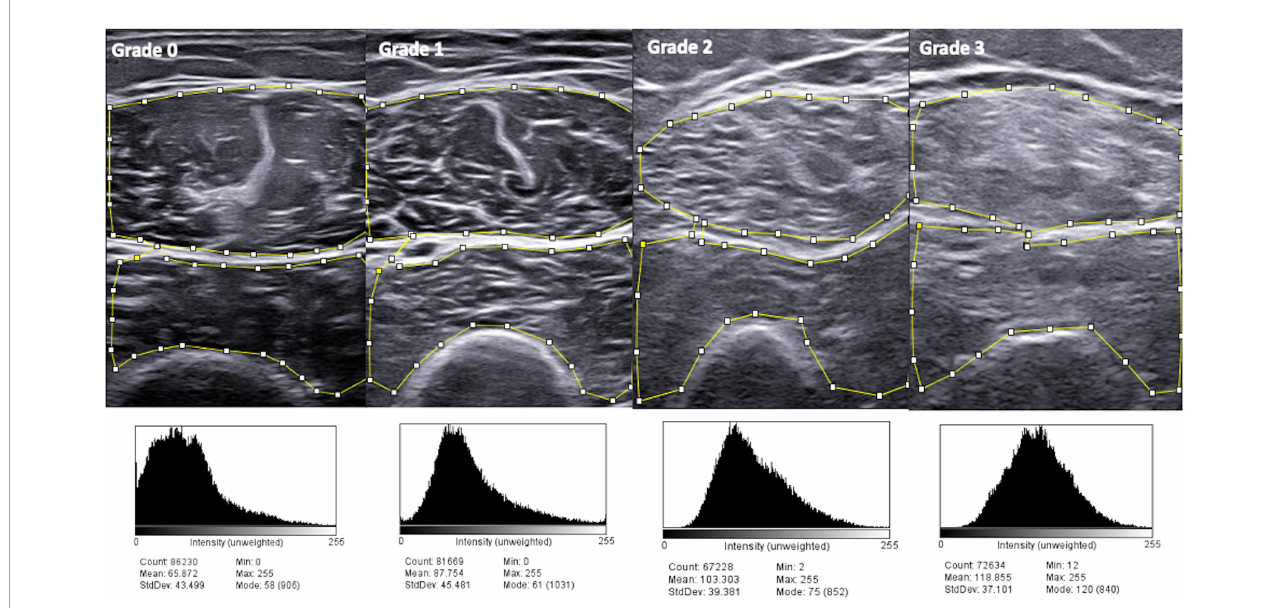
FIGURE3 ImageJ analysis in patients with different grades of muscle echogenicity. Higher grades of the visual semi-quantitative scale for muscle echogenicity correspond to higher mean pixel analysis with ImageJ. During image analysis with ImageJ, particular attention was paid to include in the region of interest (ROI) only muscle tissues (i.e., without the surrounding fascia or cortical bone), which is the area included within the small squares and